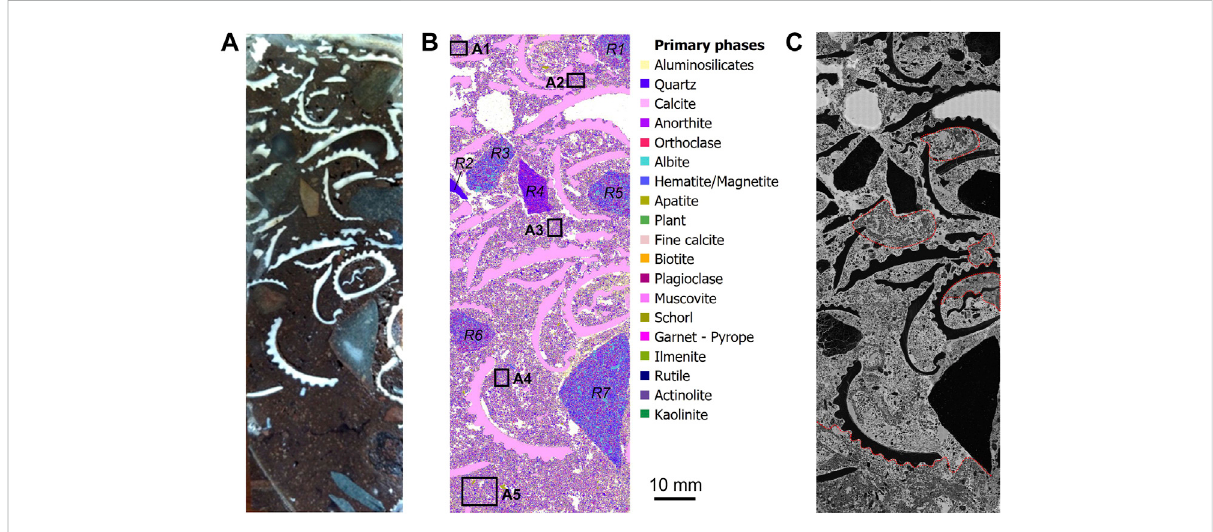
FIGURE 3 A) Scan of the resin-impregnated section of shell midden, used for TIMA analysis. ( B) TIMA mineral map showing distribution of main mineral phases, with minerals in order of abundance listed in the legend. Selected rocks (R1 – R7) and areas of sediment matrix (A1 – A4) that were also analytically sub-sampled by TMA are also marked. ( C) The mineral map of carbon shows the inhomogenous nature of the sedimentary matrix, with areas preserving evidence of faunal (ant/termite) activity outlined in red. Note areas of very high contrast re fl ect pore spaces with